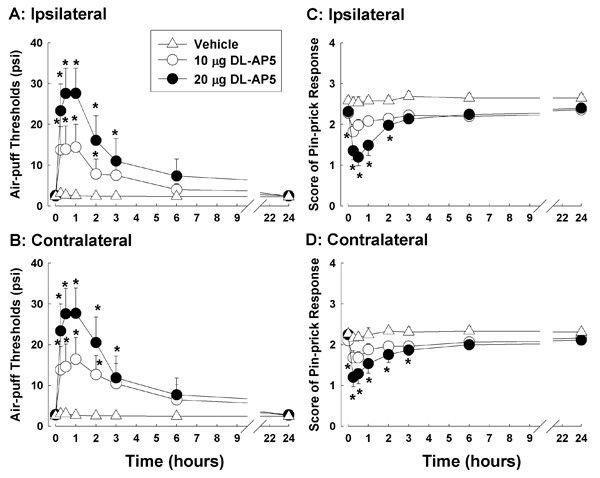
The antinociceptive effects of D-AP5 in rats with compression of the trigeminal nerve root. The effects of D-AP5, a non-selective NMDA site antagonist, on mechanical allodynia (A, B) and hyperalgesia (C, D) in rats with compression of the trigeminal nerve root (n = 8 in each treatment group). The intracisternal administration of vehicle did not affect air-puff thresholds in either the ipsilateral (A) or contralateral (B) side. However, 10 or 20 μg injections of AP5 increased the air-puff threshold significantly in a dose-dependent manner on both sides (A, B). These anti-allodynic effects of AP5 were maintained for three hours after injection. The intracisternal administration of 10 or 20 μg of AP5 also decreased the pin-prick scores ipsilateral (C) as well as contralateral (D) to the compression of the trigeminal nerve root. These anti-hyperalgesic effects of AP5 were completely recovered by six hours after injection. Vehicle injections did not affect pin-prick scores in the subject rats. *P < 0.05, vehicle-vs. AP-5-treated groups.